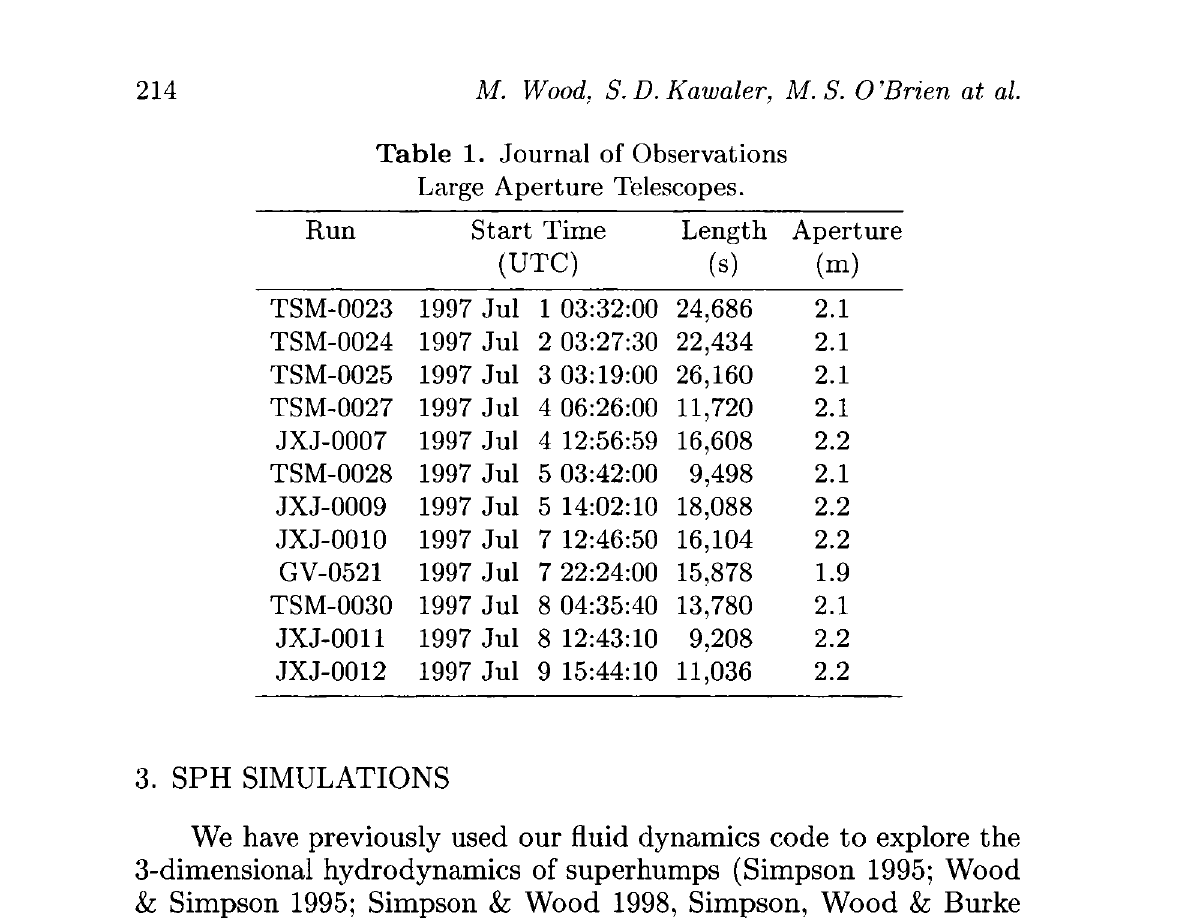
Table 1. Journal of Observations Large Aperture